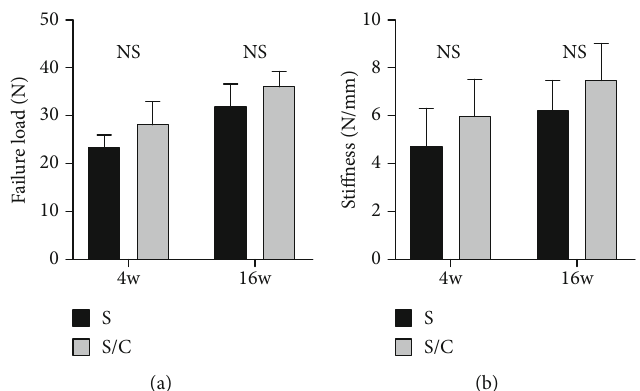
Figure 10: No signi fi cant di ff erences were found in failure load (a) or sti ff ness (b) between the S group and S/C group at 4 and 16 weeks after the reconstruction surgery. NS indicates no signi fi cant di ff erence between